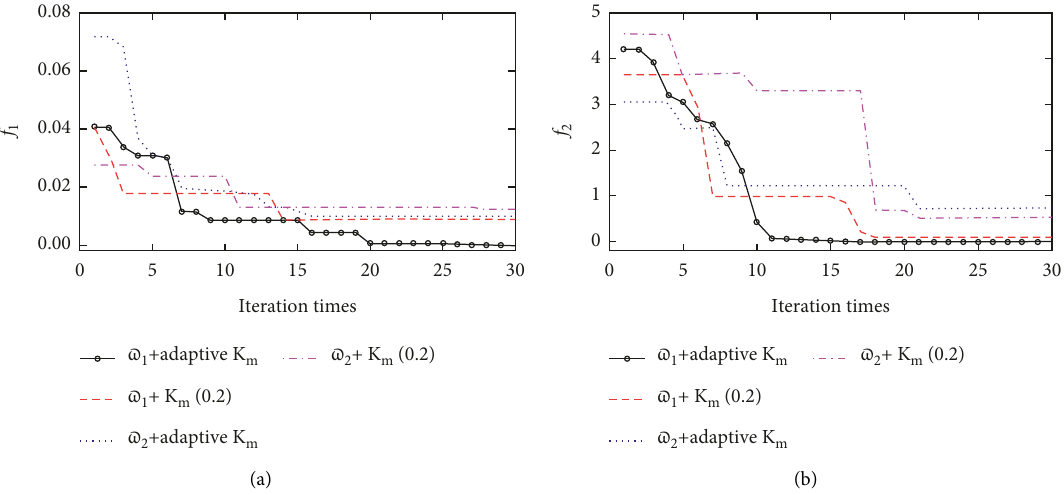
Figure 1: The decline curve of the moderate value of an objective function of the QPSO algorithm. (a) Griewank function (b) Ackley